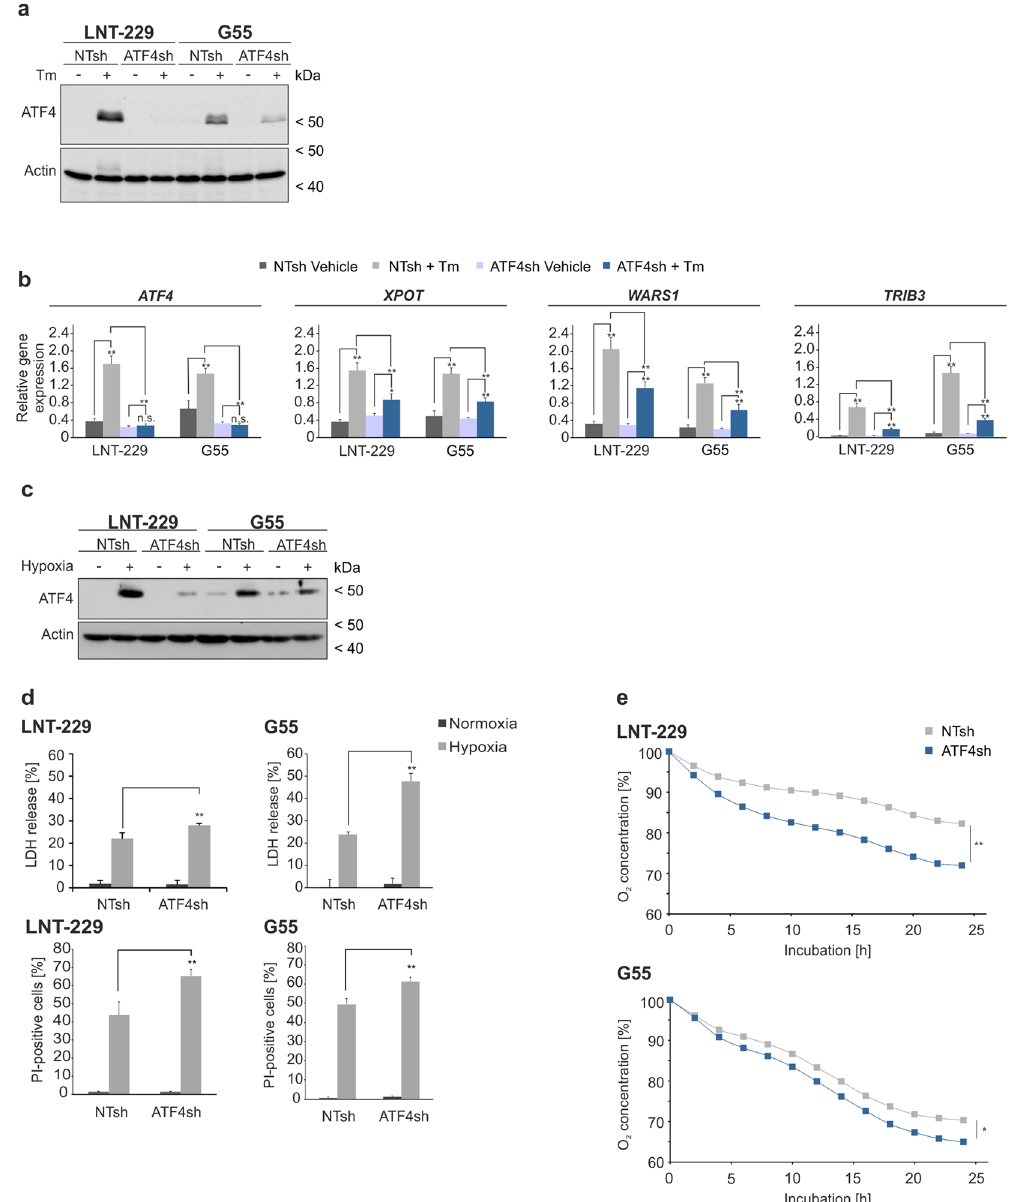
Figure 2. ATF4sh cells are insensitive for ATF4 induction via pharmacological ER stress activation and sensitized to hypoxia-induced cell death. ( a ) LNT-229 and G55 NTsh and ATF4sh cells were incubated with 2 µg/ml tunicamycin (Tm) in serum-free DMEM for 8 h. Cellular lysates were analyzed by immunoblot with antibodies for ATF4 and actin. ( b ) cDNA was analyzed by qPCR with primers for ATF4 , XPOT , WARS1 and TRIB3 (n = 3, mean ± SD, n.s. not significant, **p < 0.01, Student’s t-test). SDHA and 18S were used as housekeeping genes for normalization. ( c ) LNT-229 and G55 NTsh or ATF4sh cells were incubated in serum- free DMEM containing 2 mM glucose and 4 mM glutamine in normoxia or hypoxia (0.1% O 2 ) for 8 h. Cellular lysates were analyzed for the expression of ATF4 or actin by immunoblot. ( d ) Cells were incubated in serum- free DMEM supplemented with 2 mM glucose and 4 mM glutamine in normoxia or hypoxia (0.1% O 2 ). Cell death was analyzed by propidium iodide (PI) uptake and quantified by flow cytometry using BD FACS Diva software (version 6.1.3) (n = 3, mean ± SD, **p < 0.01, Student’s t-test) or by LDH release assay (n = 4, mean ± SD, **p < 0.01, Student’s t-test). ( e ) Oxygen consumption of LNT-229 and G55 NTsh and ATF4sh cells was measured in serum-free DMEM supplemented with 2 mM glucose and 4 mM glutamine overlaid with paraffin oil with a fluorescence-based assay. Oxygen consumption is shown relative to the start of the experiment (n = 3, mean, *p < 0.05, **p < 0.01, Student’s